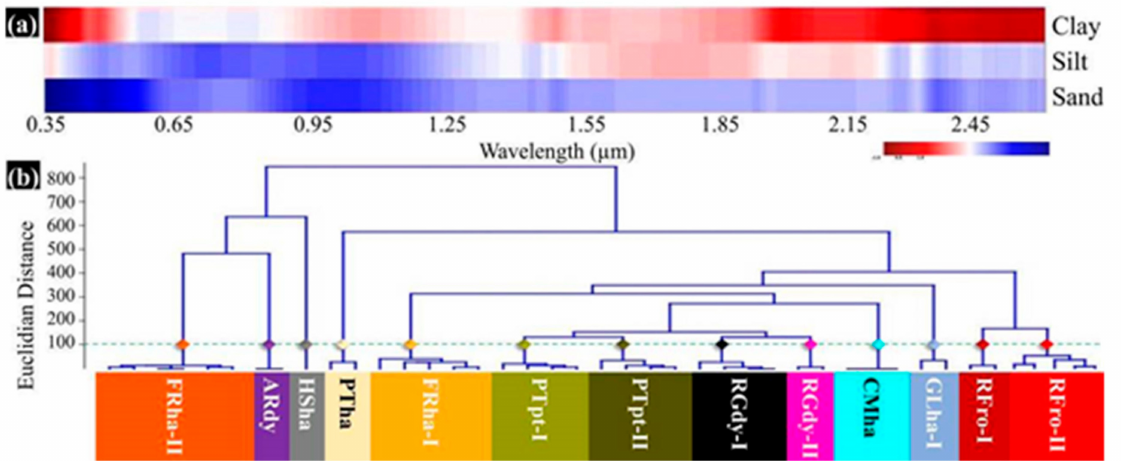
Figure 4. ( a ) Pearson’s correlation between texture and spectral signatures; ( b ) texture-based hierarchical cluster analysis. FRro-I and FRro-II: Rhodic Ferralsol; FRha-I and FRha-II: Haplic Ferralsol; PTpt-I and PTpt-II: Petric Plinthosol; PTha: Haplic Plinthosol; RGdy-I, RGdy-II: Dystric Regosol; CMdy: Dystric Cambisol; GLha: Haplic Gleisol; HSha: Haplic Histosol; and ARdy: Dystric